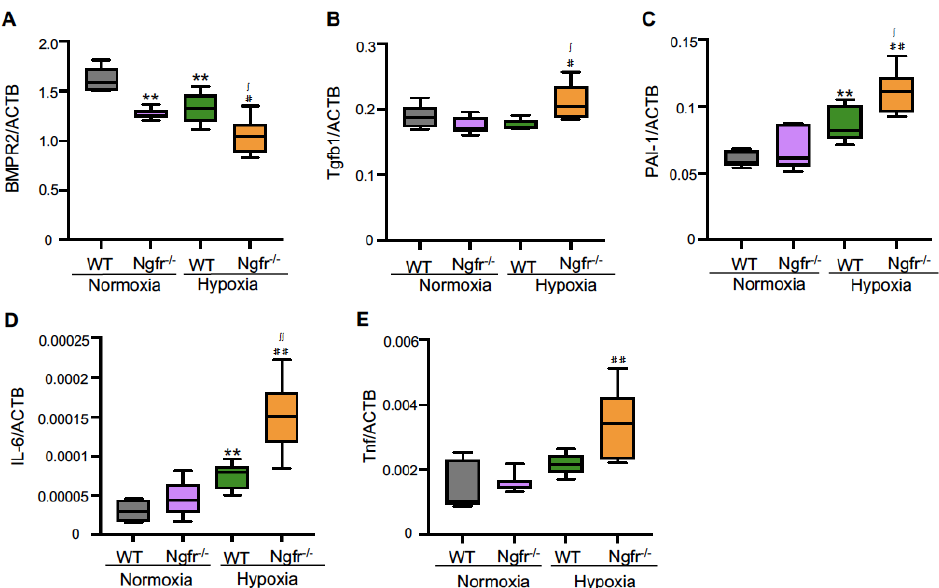
Figure 5. Gene expression profiles in lung tissue. Gene expression of BMPR2, Tgfb1, PAI-1, IL-6, and Tnf in WT and Ngfr − / − mice under normoxic and hypoxic conditions. Gene expression of ( A ) BMPR2, ( B ) Tgf-b1, ( C ) PAI-1, ( D ) IL-6, and ( E ) Tnf in WT and Ngfr −/− mice under normoxic and hypoxic conditions. BMPR2, bone morphogenetic protein receptor type 2; Tgf-b1, transforming growth factor-b1; PAI-1, plasminogen activator inhibitor-1; IL-6, interleukin-6; Tnf, tumor necrosis factor. Center lines show the medians, box limits indicate the 25th and 75th percentiles, whiskers extend 1.5× the interquartile range from the 25th and 75th percentiles. ** p < 0.01 versus WT Normoxia. # p < 0.05 and ## p < 0.01 versus Ngfr −/− Normoxia. ∫ p < 0.05 and ∫∫ p < 0.01 versus WT Hy- poxia.